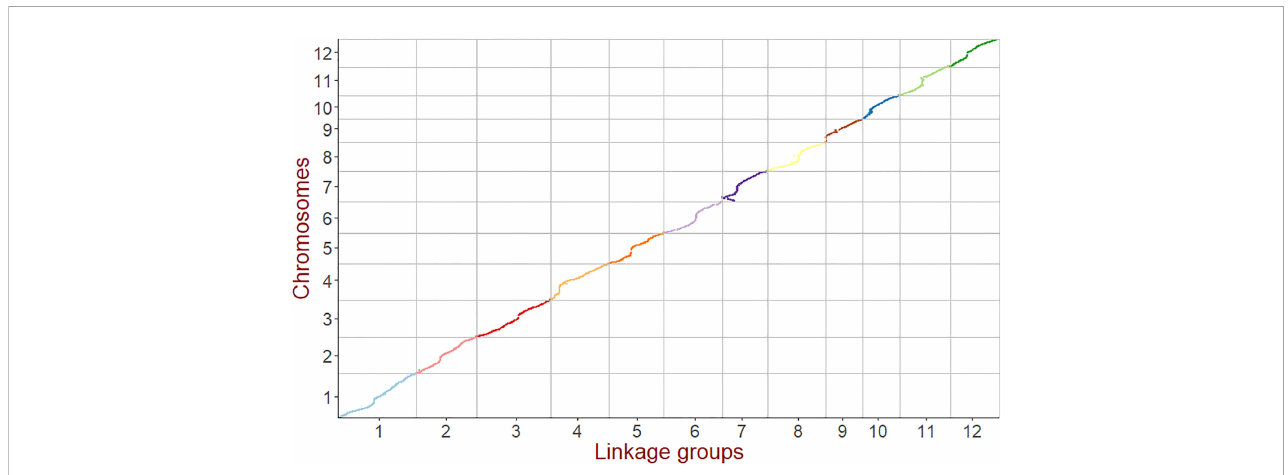
FIGURE 1 Collinearity analysis of the genetic map and genome. The x-axis is the genetic distance of each linkage group. The y-axis is the physical length of each chromosome, with the collinearity of genomic markers and genetic maps represented in the scatter plot. Different colors represent different chromosomes or linkage